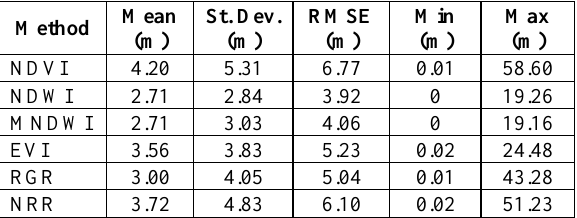
Table 3. DRI statistical values for the extracted coastlines using coastline extracted from Lg-DEM as reference.